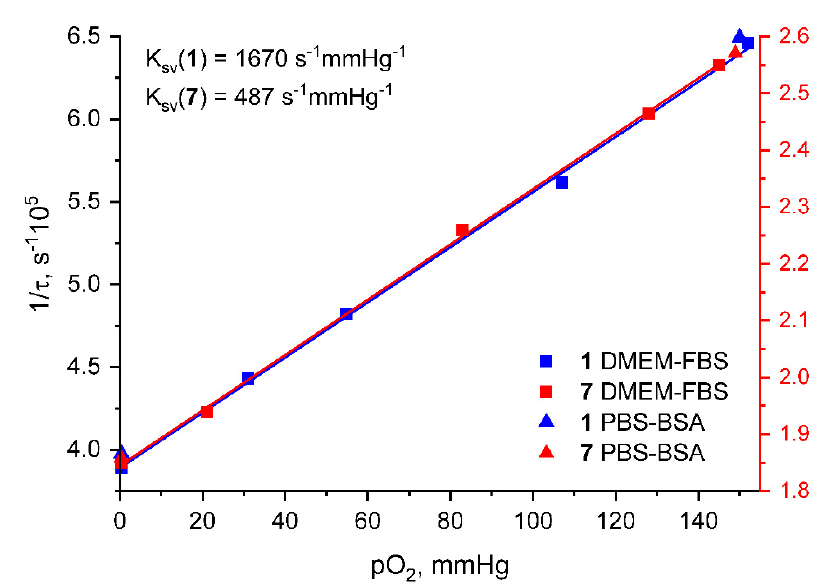
Figure 3. Stern-Volmer oxygen quenching plots for 1 (blue symbols and lines) and 7 (red symbols and lines) in the aqueous DMEM-FBS-PEG(200) (squares) and PBS-BSA-PEG(200) (triangles) solutions at different partial pressures of oxygen. Temperature 310 K, excitation at 355 nm, data acquisition at 720 nm. Media composition: FBS, 10% v/v ; DMEM, 88.5% v/v (for complex 1 ) and 87.5% v/v (for complex 7 ); PBS (0.01 M, pH 7.4), 98.5% v/v (for complex 1 ) and 97.5% v/v (for complex 7 ); PEG (200), 1.5% v/v (for complex 1 ) and 2.5% v/v (for complex 7 ); concentration of BSA, 50 µM; concentration of 1 = 5 µM; concentration of 7 = 10 µM. Table 2. Lifetime data for complexes 1 and 7 in aqueous solutions at different partial pressures of oxygen, 310 K, excitation at 355 nm, data acquisition at 720 nm.